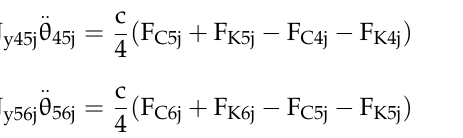
Figure 3. Model of the air suspension system: ( a ) Physical model, ( b ) GENSYS model. Displacements z ij , ξ ij , and w ij are the displacements of the upper part of the air spring, the lower part of the air spring, and of the air flow inside the pipes, respectively.